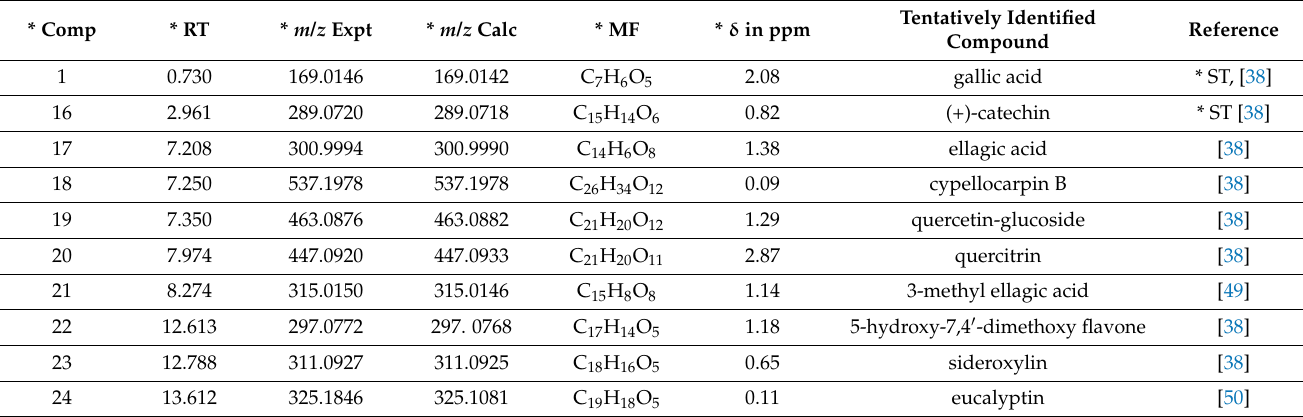
Table 4. Tentative assignment of compounds in Eucalyptus rossii leaves (crude extract).